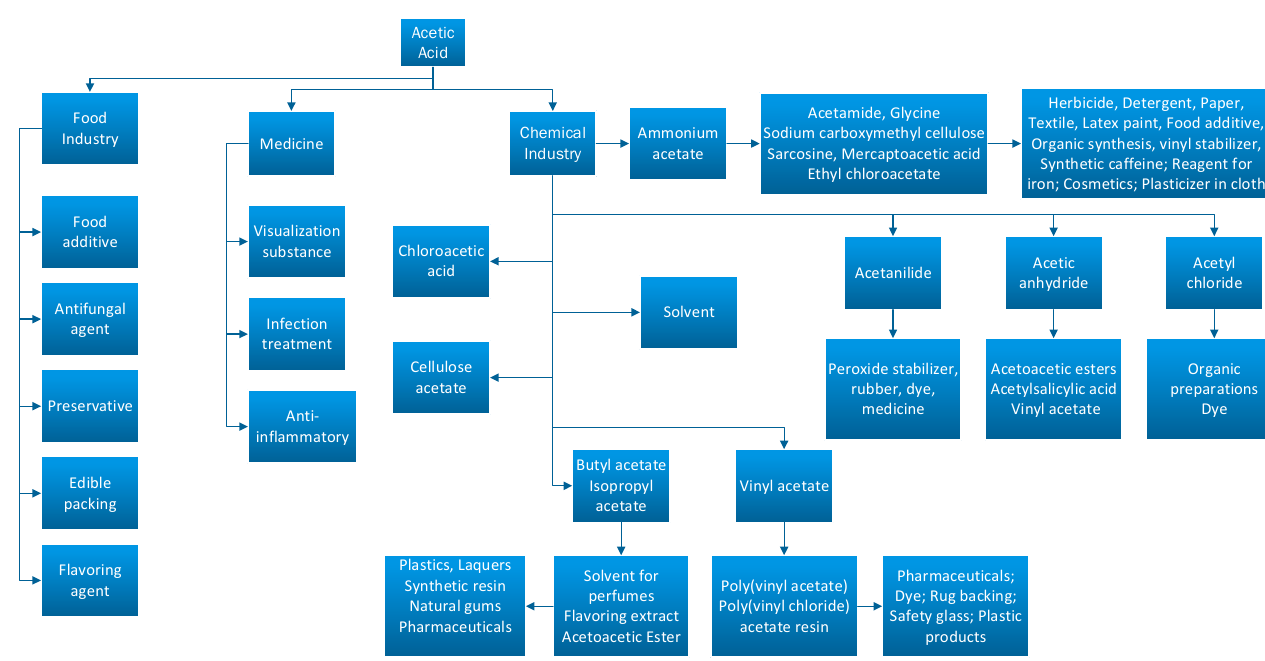
Figure 1. Acetic acid conversion routes in the industry